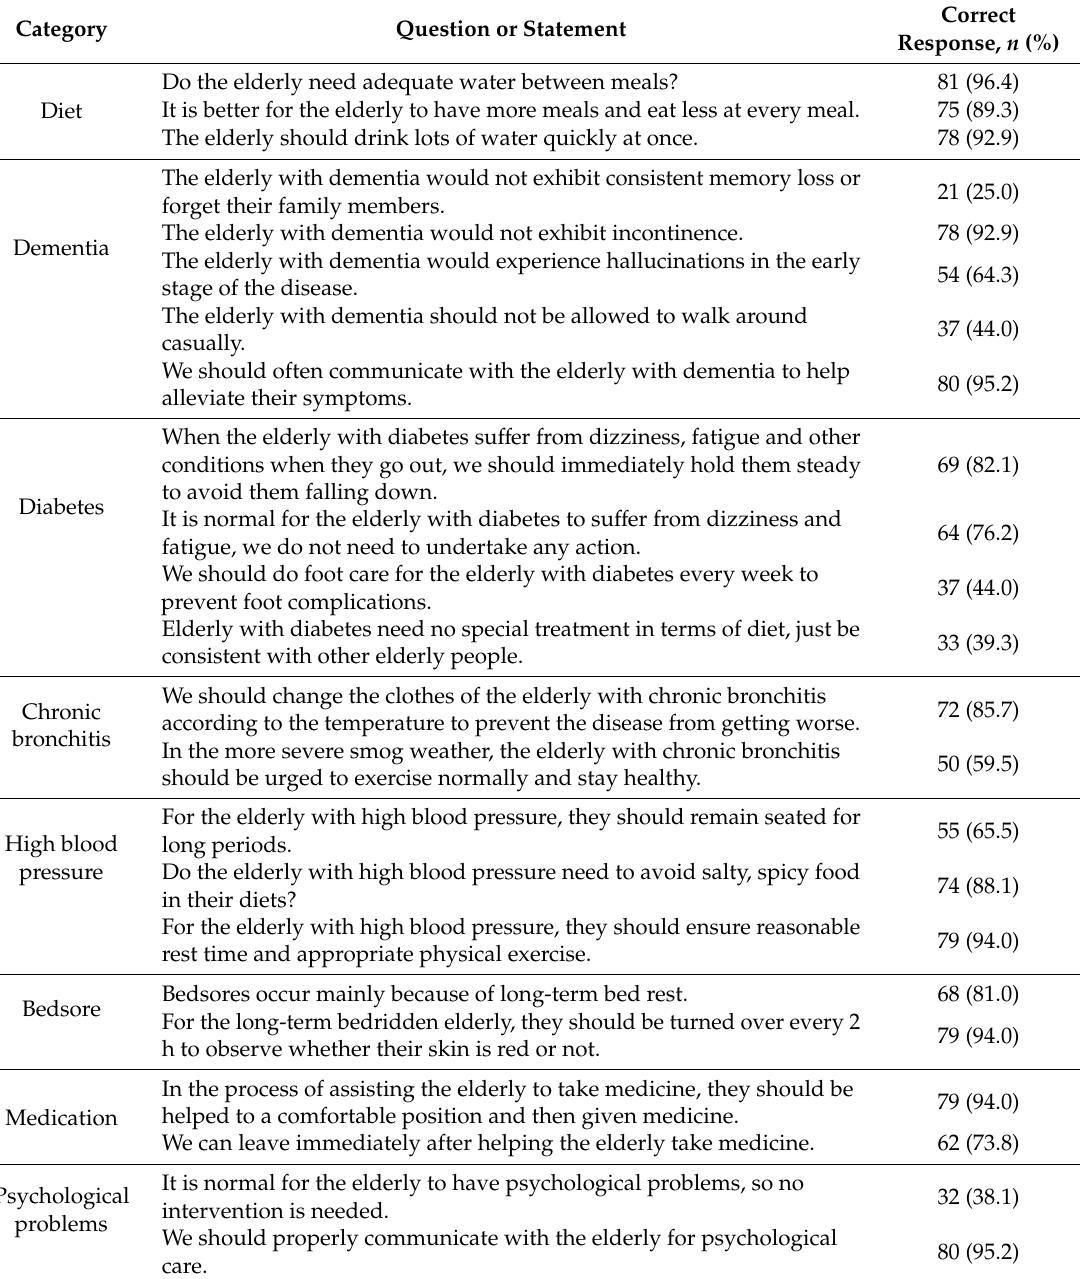
Table 2. Respondents’ knowledge on elderly